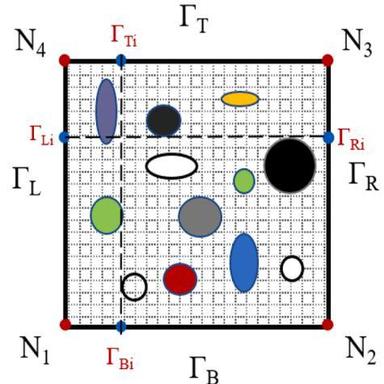
A schematic representation of the prescribed periodicity boundary condition for a typical two-dimensional RVE.